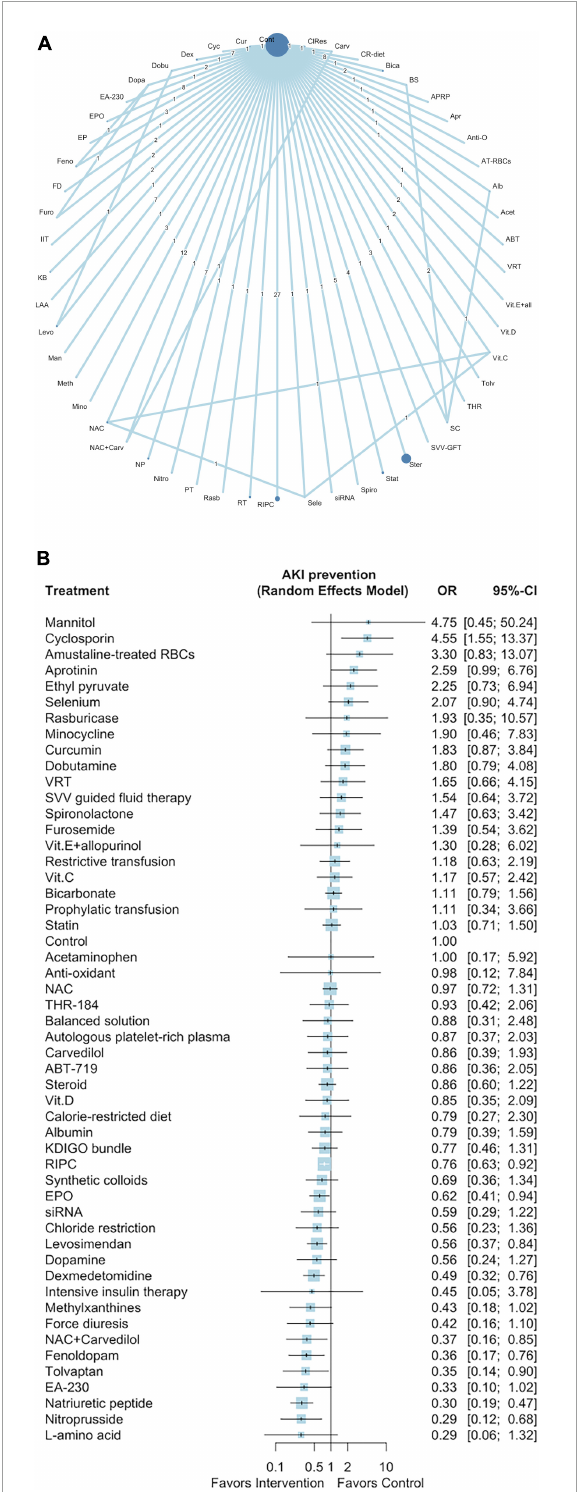
FIGURE1 Network plot of eligible comparisons among interventions for AKI prevention (A) , Forest plot of network meta-analysis for AKI prevention (B) . In the network plot, the size of each